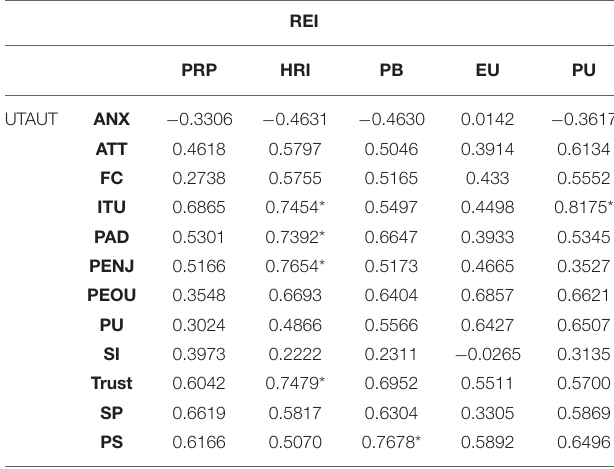
TABLE 5 | Correlation coefficients with the Robot-Era Inventory scales and the UTAUT scales after the Bonferroni